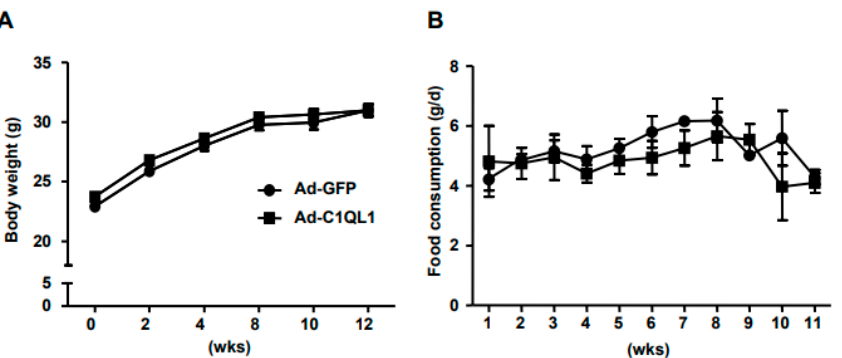
Figure 2. Body weight and food consumption. ( A ) The body weight of ApoE KO mice. ( B ) Food consumption of ApoE KO mice. n = 15 of each cohort. Mean ± SEM.